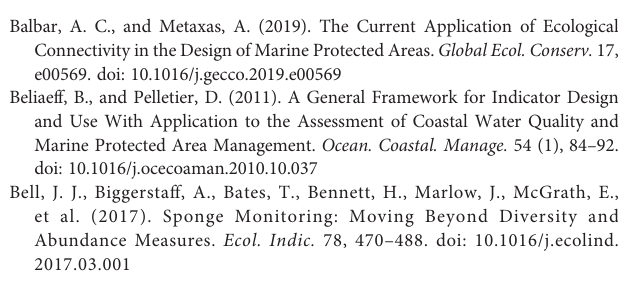
Supplementary Table 1 | Extensive list of indicators. Supplementary Table 2 | Shortlist of prioritized indicators. Supplementary Table 3 | Indicators' survey methods. Supplementary Table 4 | Correspondence between the prioritized indicators and national